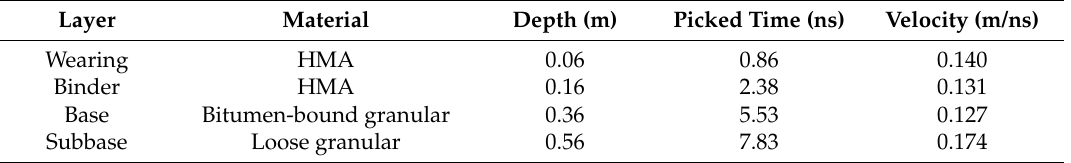
Table 4. Interpretation of the GPR depth section depicted in Figure 11.